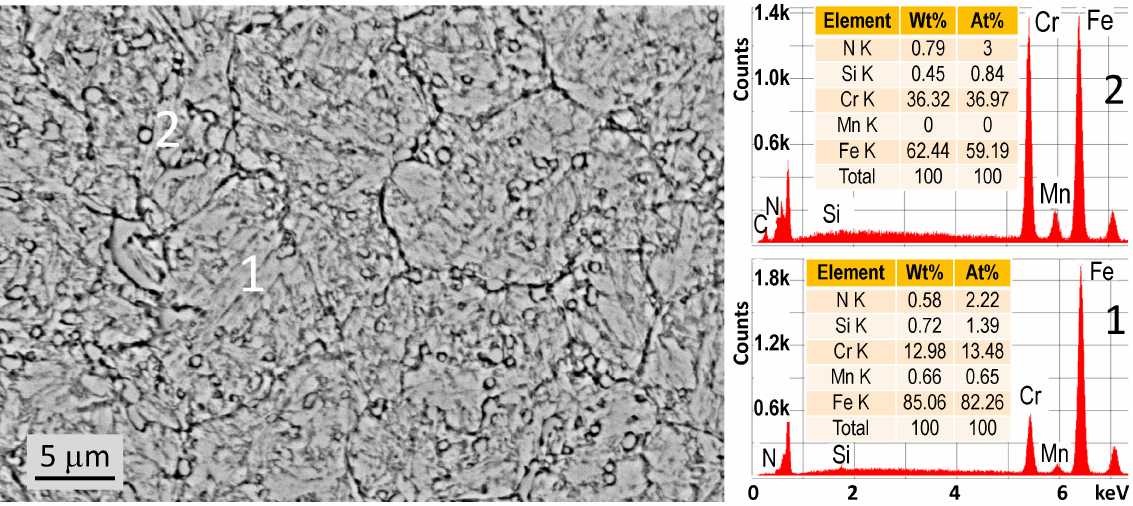
Figure 1. The SEM image of the secondary-hardened (quenched and highly tempered) substrate along with the EDX spectra in the indicated two spots (etchant: Nital 5%).